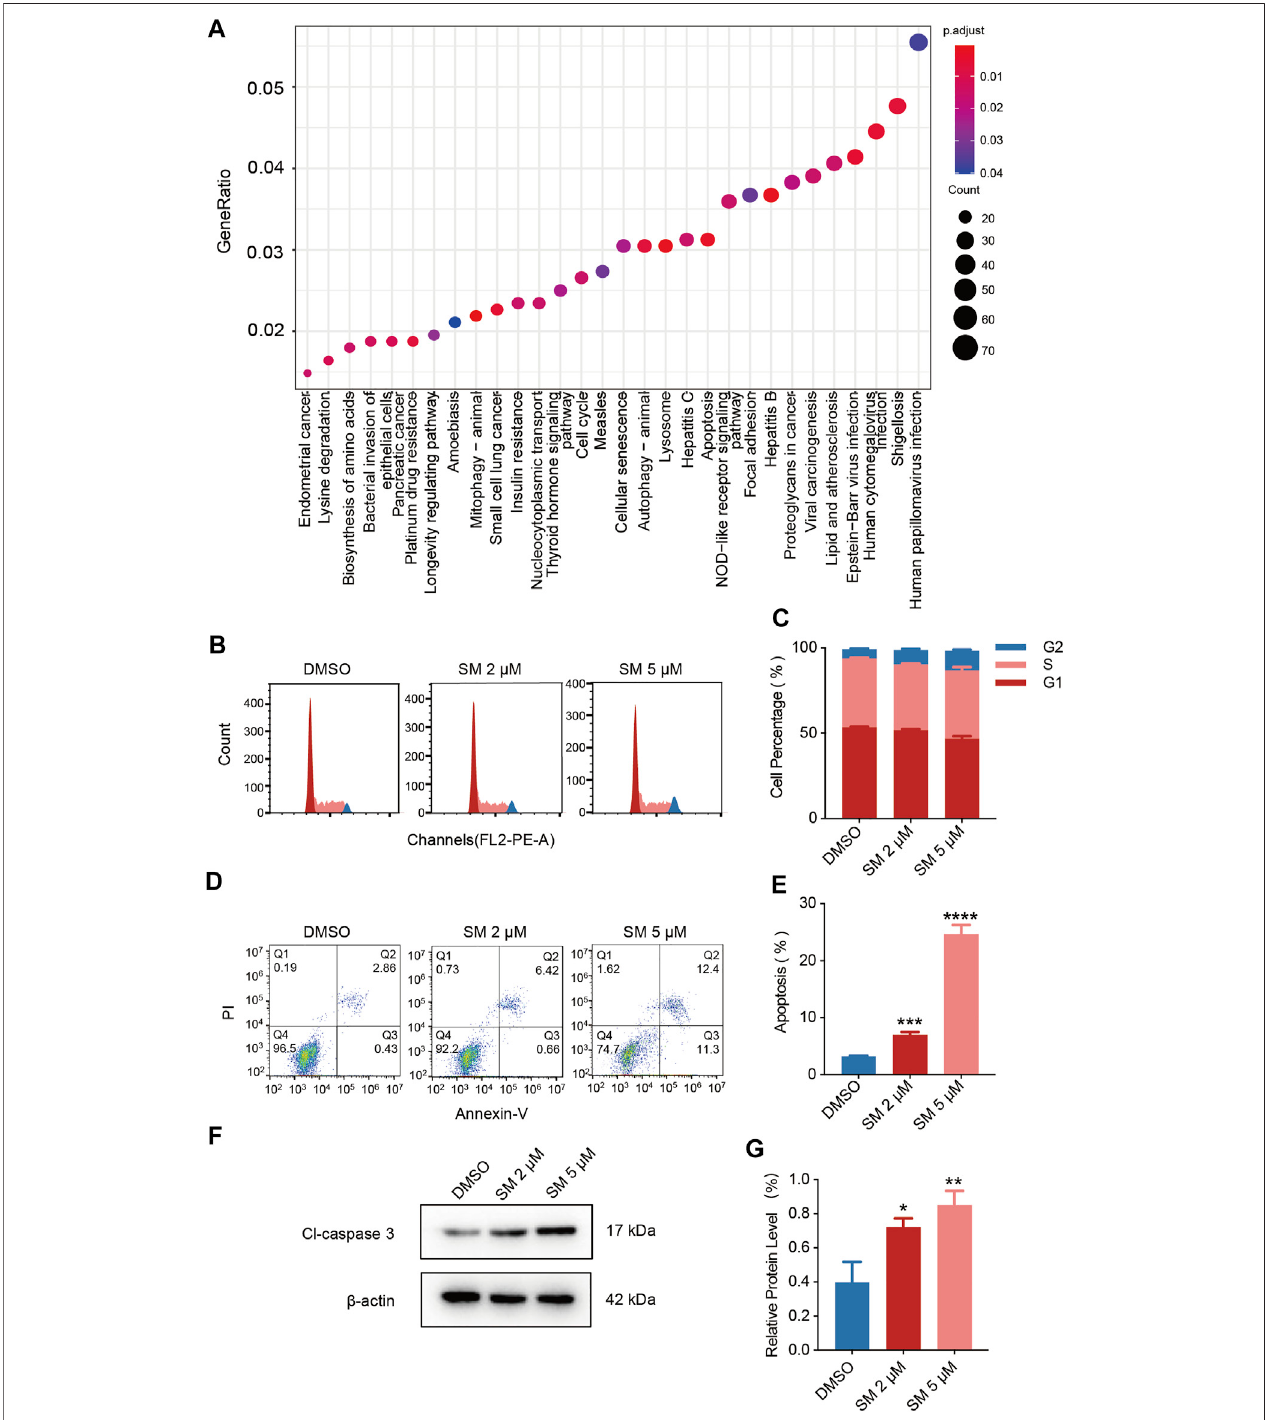
FIGURE 2 | SM mediates apoptosis and cycle arrest in FaDU cells. (A) Enriched KEGG pathways of differentially expressed mRNAs in FaDU cells after 5 μ M SM treatment. p -value < 0.05. (B,C) Cell cycle assay was examined by fl ow cytometry in FaDU cells treated with DMSO and 2 and 5 μ M SM. The result was analyzed using FlowJo software. (D,E) Apoptosis of FaDU cells treated with DMSO and 2 and 5 μ M SM was analyzed using fl ow cytometry, and the total apoptosis proportion was calculated by FlowJo software. (F,G) Effect of SM on apoptosis determined by the level of the cleaved caspase-3 protein. *( p < 0.05), **( p < 0.01), ***( p < 0.001), and ****( p < 0.0001) indicate statistically signi fi cant differences.